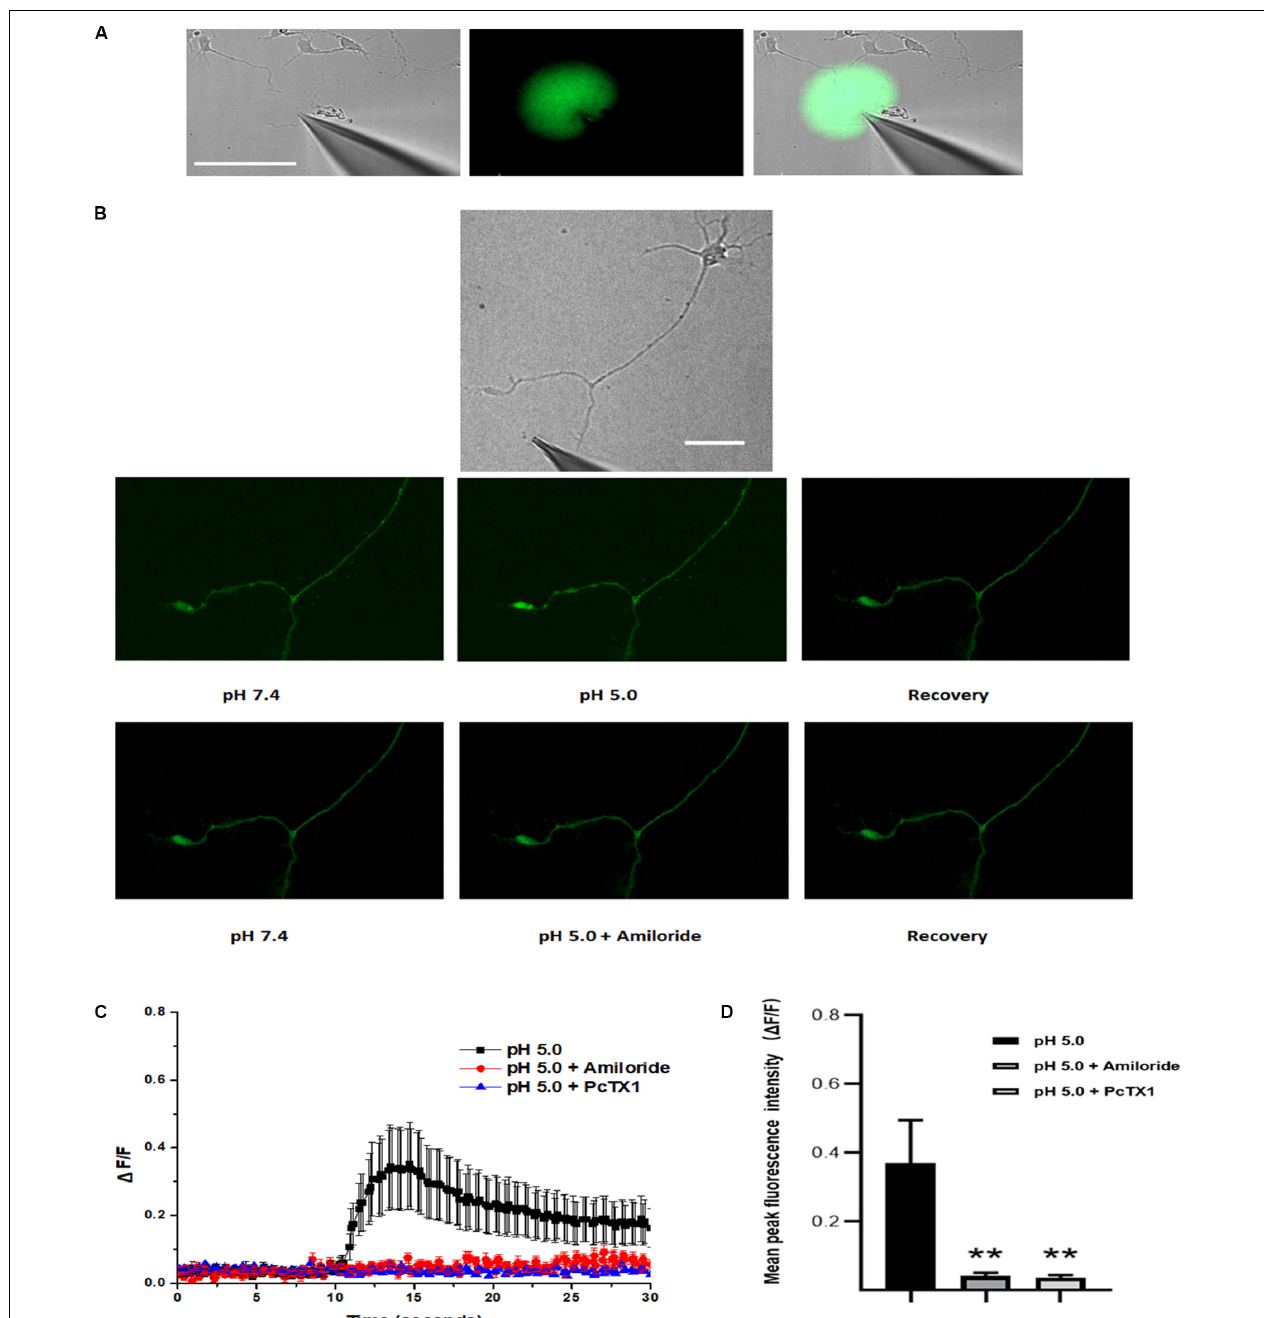
FIGURE 4 | Activation of ASICs at axonal growth cones leads to calcium influx. DIV3-DIV6 hippocampal neurons were loaded with Fluo-4 AM calcium indicator. (A) DIC image of the experimental system (left). To examine the area of the pressure application, a spray delivery electrode was loaded with a mixture of Alexa Fluor 488 and HBSS (volume ratio 1:10) and applied to the growth cone. Fluorescent signals of the application were pseudo-colored based on pixel intensity (middle). The fluorescent image was digitally merged with a DIC image of the experimental system for visualization purposes (right). Scale bar, 100 µ m. (B) Representative DIC image of the experimental system (top). Local application of acid solution to the growth cone induces calcium influx (middle). Adding 200 µ mol/L amiloride to the extracellular solution in advance eliminates the ASICs-mediated calcium influx (bottom). Scale bar, 40 µ m. (C) (cid:49) F/F analysis reveals an significant increase in fluorescence (calcium transients) at the growth cone after local application of acid solution (black square) ( n = 12). Application of 200 µ mol/L ( n = 8) amiloride and 50 nmol/L PcTX1( n = 4) to the extracellular solution blocked ASICs-mediated calcium transients (red circle and blue triangle), respectively. Experiments were performed in the presence of TTX, VSCCs blockers (nimodipine, MVIIA and ω -agatoxin IVA), and CPA (which blocks the replenishment of intracellular calcium stores). (D) Mean peak fluorescence intensity ( (cid:49) F/F) is statistics from experiment illustrated in (C) . Data are means ± SEM, and analyzed by one-way ANOVA followed by Tukey’s multiple comparisons test, **p <